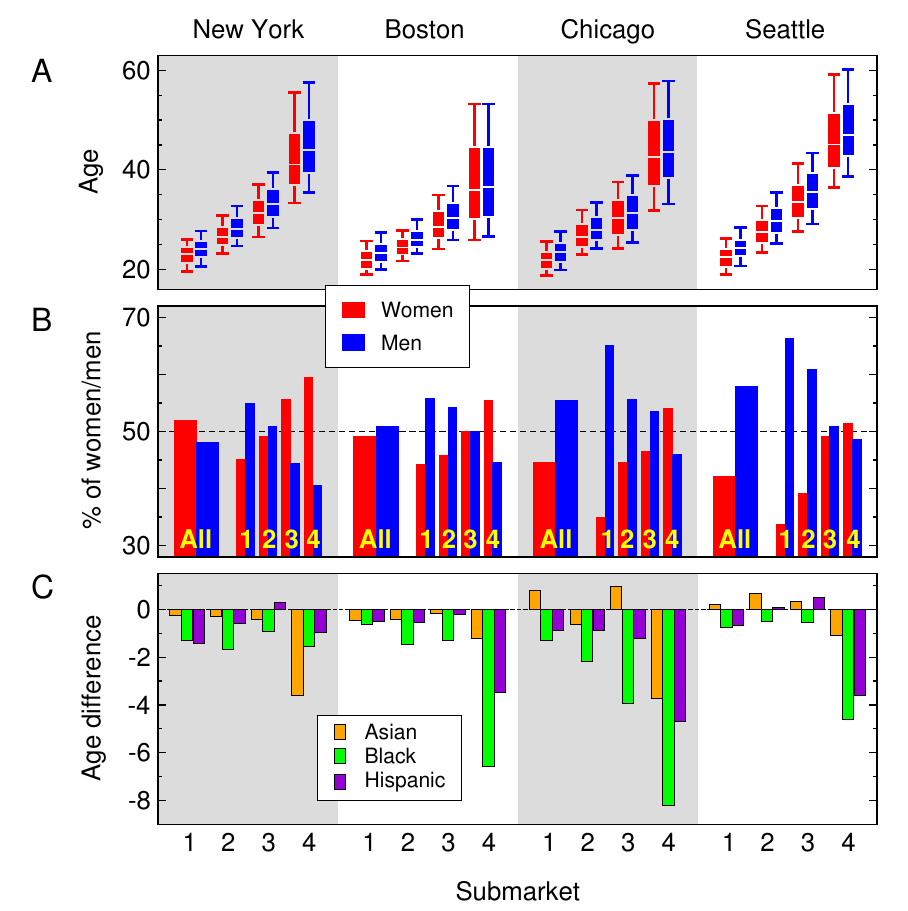
Figure 2: (A) Distribution of ages of men and women in each submarket in each of the four cities studied. Boxes indicate the 25th, 50th, and 75th percentiles; whiskers indicate the ninth and 91st percentiles. (B) Percentage of men and women in each submarket, and overall, for each city. (C) Average age of minority women in each submarket by ethnicity, measured relative to average age of white women in the same submarket. Units of analysis are